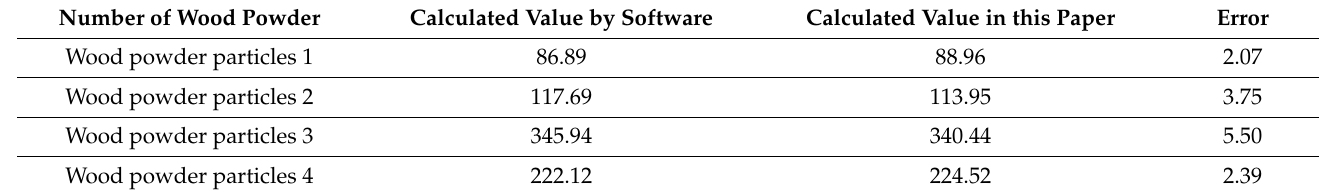
Table 4. Mesh value and error φ